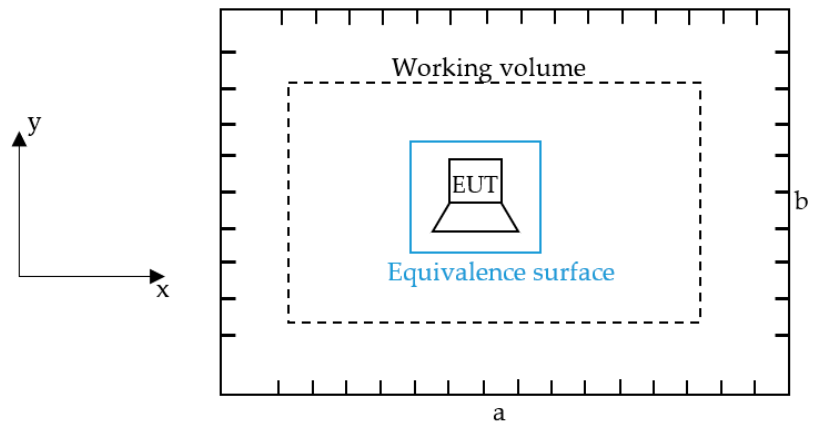
Figure 1. The scenario: an RC, its dimensions, the working volume, and the equivalence surface surrounding the EUT.